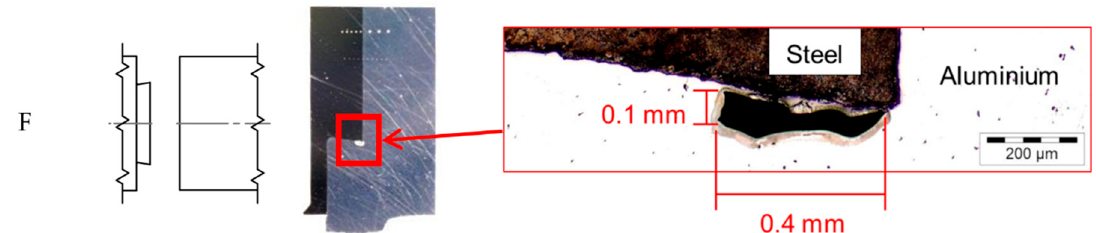
Figure 10. Geometry F, ( left ) schematic draft, ( middle ) overview of a nearly half-cut sample, and ( right ) exemplary air inclusion at the undercut.